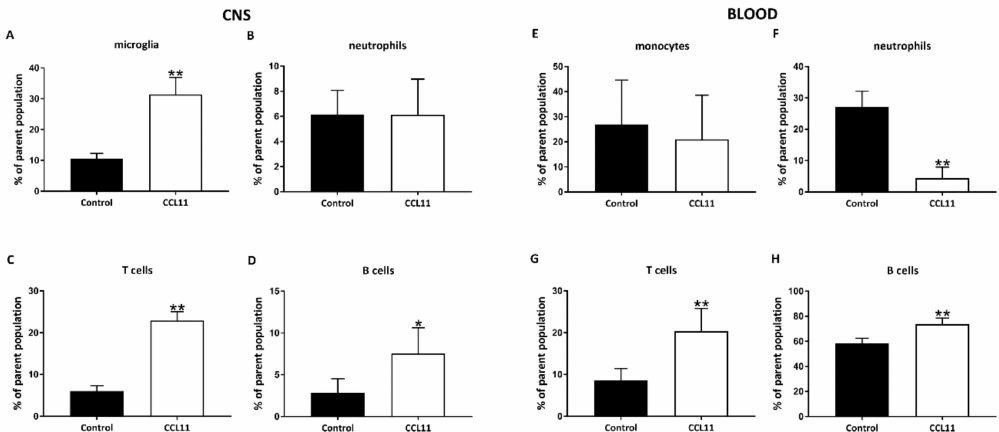
Figure 6. CCL11 modifies subacute central and systemic immune responses in post-stroke adolescent mice. C57BL6 male mice with an age of six weeks were subjected to cerebral ischemia for 45 min followed by reperfusion for 7 days. At the beginning of the reperfusion, mice received intraperitoneal injections of either 10 µ g / kg bodyweight of CCL11 or 100 µ L of PBS as control and daily on the seven consecutive days after reperfusion. Flow cytometry was analyzed with FlowJo software. ( A – D ) shows the quantitative analysis of adolescent animals of ( A ) CD45 int cells, **significantly di ff erent from the corresponding control, p = 0.007. ( B ) shows Ly6G + cells, ns p = 0.690. ( C ) displays CD3 + cells, **significantly di ff erent from the corresponding control, p = 0.007, and ( D ) shows CD19 + cells, *significantly di ff erent from the corresponding control, p = 0.031, as measured in the CNS. In ( E – H ) the quantitative analysis of the adolescent animals of ( E ) CD45 int cells was performed, ns p > 0.999, ( F ) depicts Ly6G + cells, **significantly di ff erent from the corresponding control, p = 0.007. ( G ) shows CD3 + cells, **significantly di ff erent from the corresponding control, p = 0.007, and ( H ) demonstrates CD19 + cells, **significantly di ff erent from the corresponding control, p = 0.007, as measured in the blood. The number of mice was n = 5 in each group. All data are given as means ±